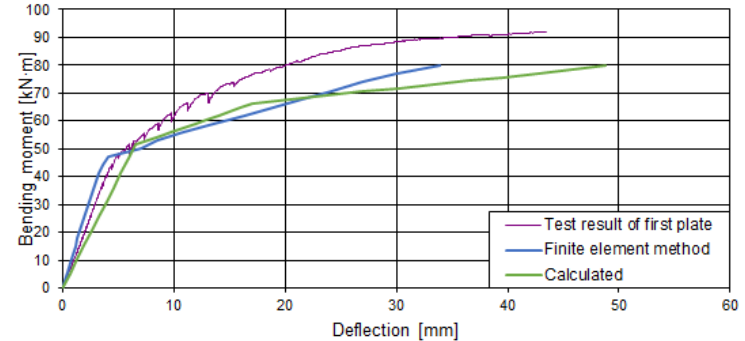
Figure 19. Comparison of the deflections of the first slab (I pl).